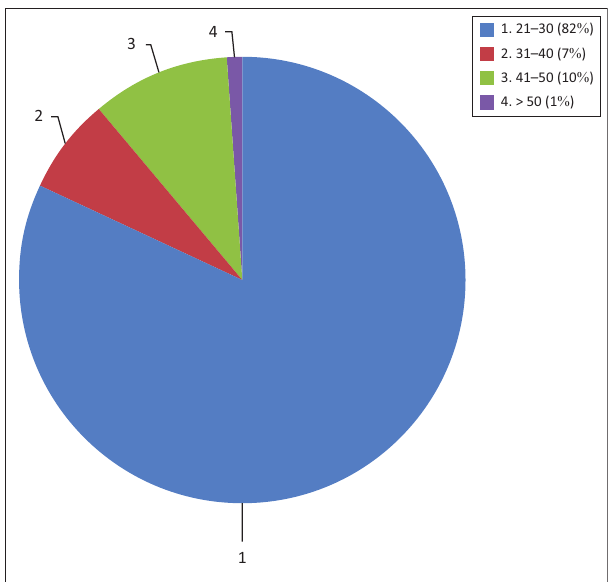
FIGURE 1: Pie chart showing the age distribution of participants.